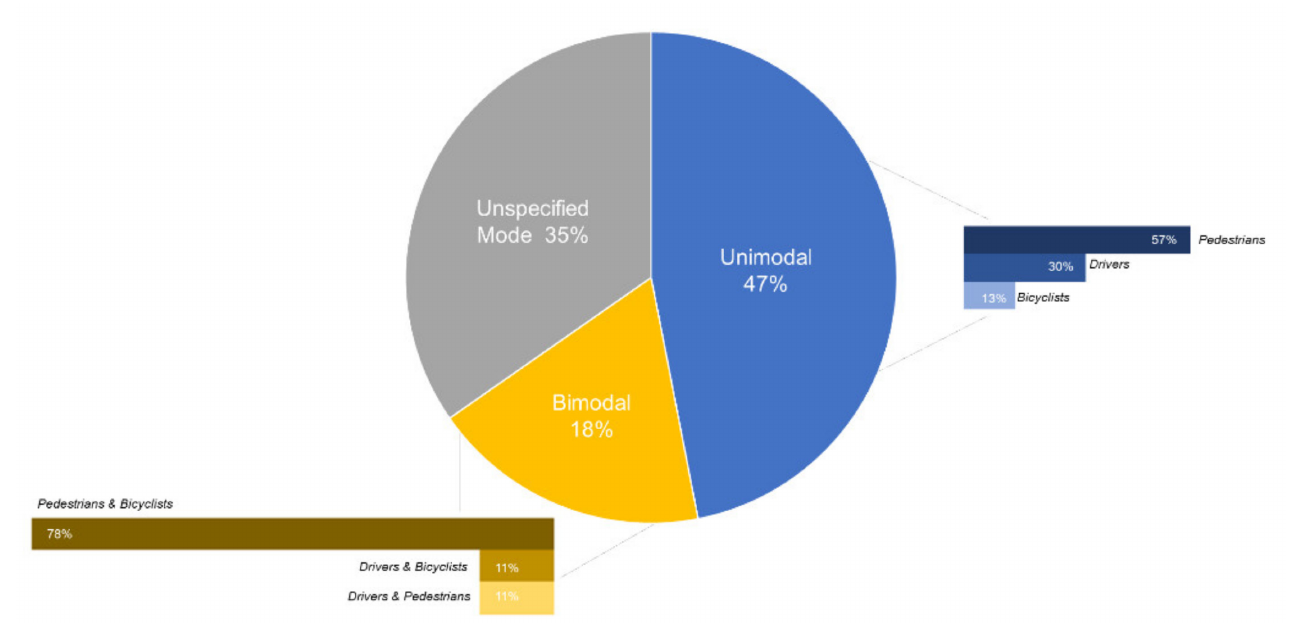
Figure 2. Type and distribution of circulation